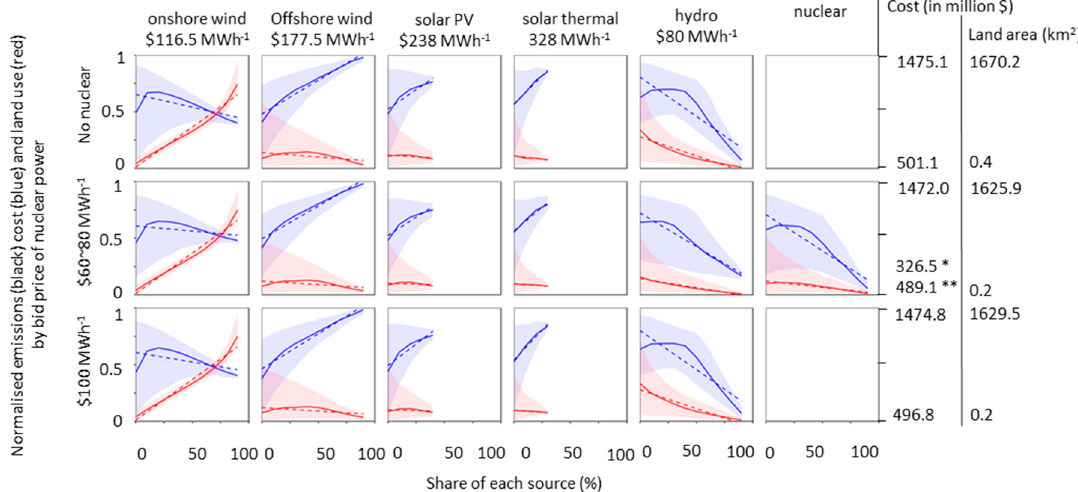
Figure 3. Tasmania example: cost (blue) and land use (red) and its median for each section (continuous) based on incremental 5% changes in the share of each source of total annual generation, along with regression graphs (dotted) showing the share of each electricity source. Each plot is redrawn from the same output to display the changes by share of each source. Note that the current greenhouse-gas emissions from electricity generation are 0 in Tasmania owing to its near-exclusive reliance on hydroelectric power (if inter-connector trading to the mainland is disregarded). * Minimum generation cost when the average generation cost of nuclear power is $60 MWh − 1 . ** Minimum generation cost when the average generation cost of nuclear power is $80 MWh − 1 .